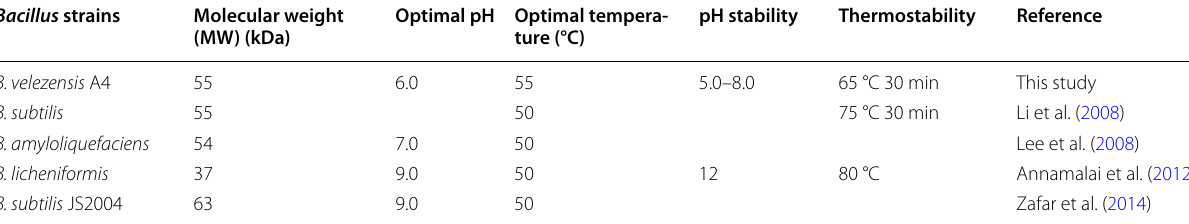
Table 2 Endoglucanase properties from different Bacillus strains Bacillus